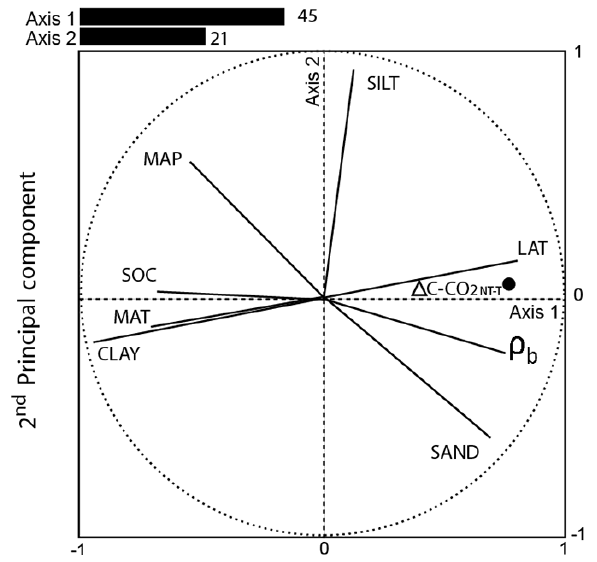
Figure 9. Principal components analysis (PCA) using the differ- ent environmental factors as active variables and soil CO 2 emission difference between T and NT ( (cid:49) CO 2 T − NT ) as the supplementary